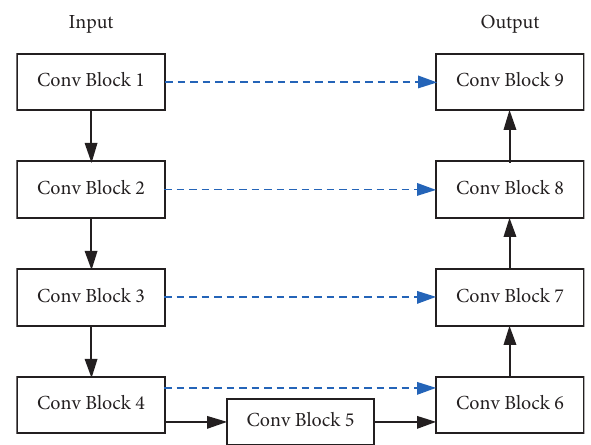
Figure 4: The structure of the deep learning network. The array of input data is a 4-dimensional data converted from the original RAW image. The convolutional block is abbreviated as “Conv Block,” which represents a convolutional block including 2D convolutional layers and a pooling layer. The blue dotted arrow represents copy and crop